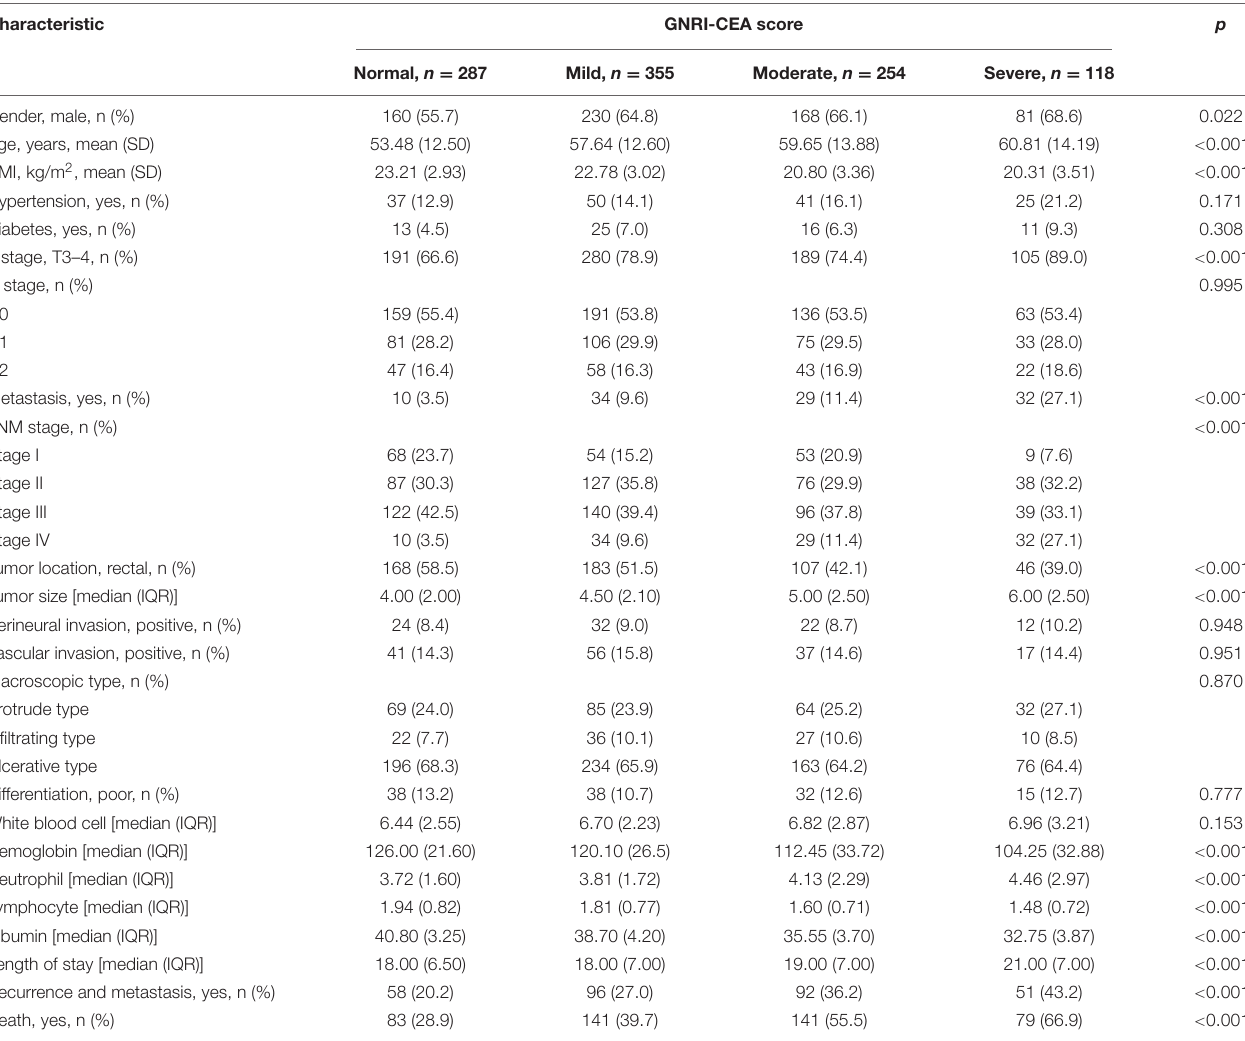
TABLE 1 | The relationships between the GNRI-CEA score and clinicopathological factors of CRC patients.